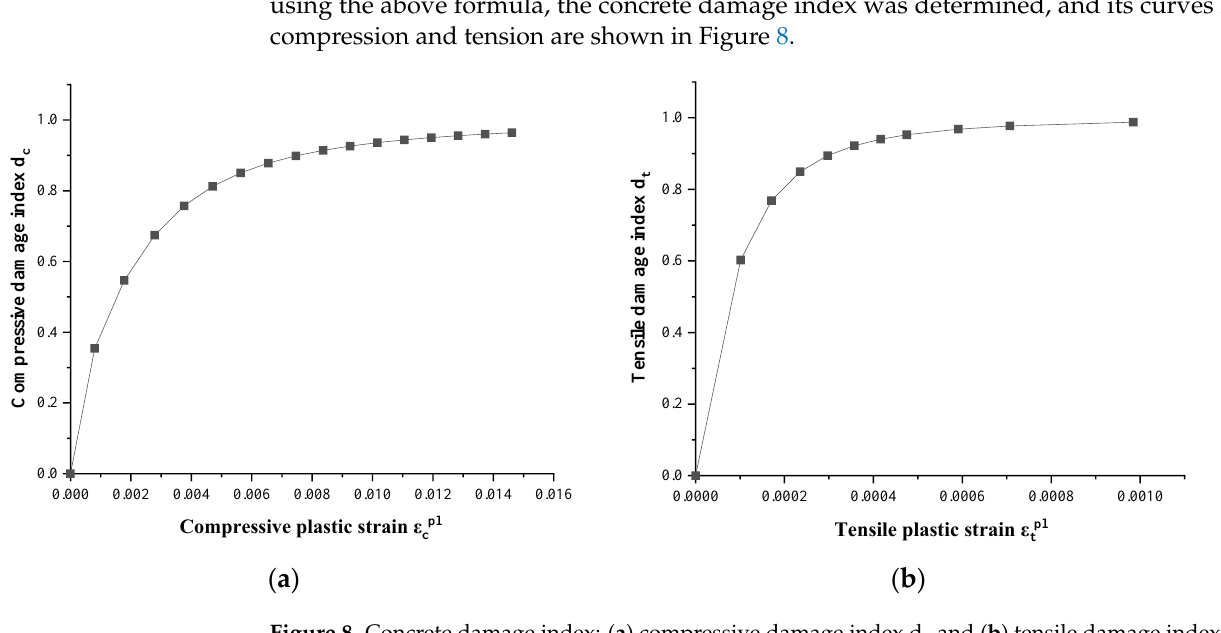
Figure 8. Concrete damage index: ( a ) compressive damage index d c and ( b ) tensile damage index d t .